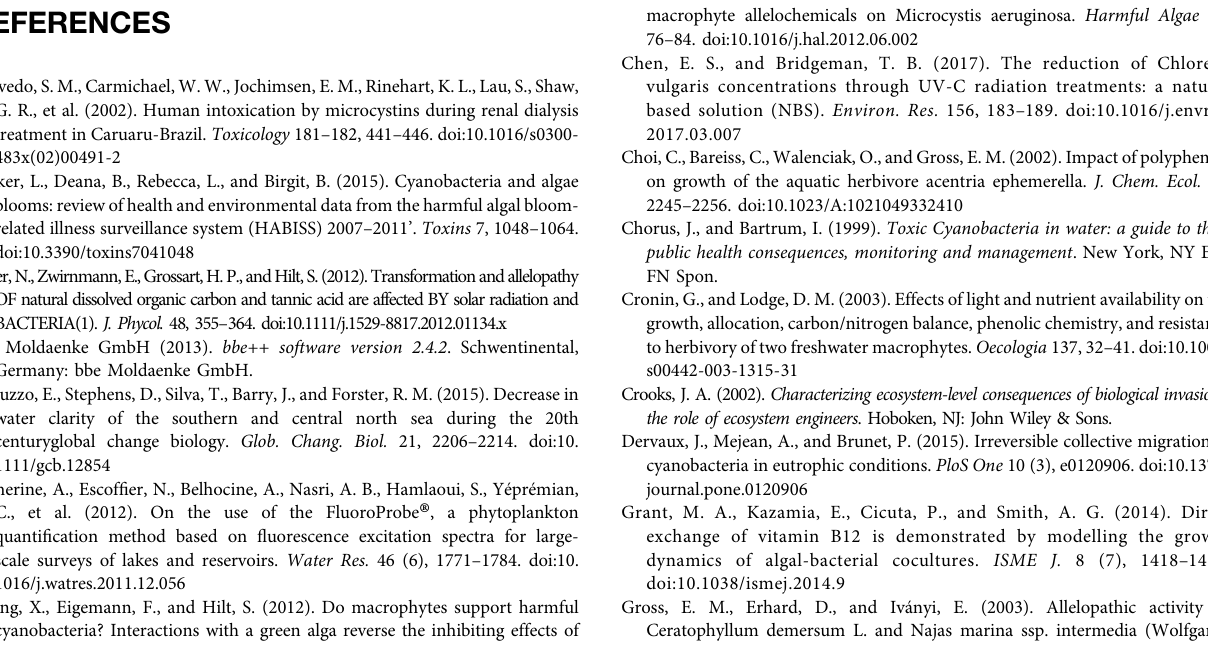
SUPPLEMENTARY FIGURE S1. The change in the number of phytoplankton cells over time under varying conditions. All fi gures are linear regression models indicating the average change in the number of cells between the different treatments. The shaded grey area represents the 95% con fi dence interval. The dotted line across the bottom of each graph represents 0 cells per ml. The solid red line represents Chlorella cell numbers, and the dashed blue line represents Synechocystis cell numbers. The red and blue circles represent the average Chlorella and Synechocystis cell numbers at each time point respectively, the error bars indicate the standard error. The underlined red numbers indicate the intercept, coef fi cient, R2 value and P value of the regression models relating to Chlorella. The blue, non-underlined numbers, represent the same values for the regression models relating to Synechocystis. Figures (a) , (b) and (c) , represent the results for each plant type, H. ranunculoides, C. helmsii and Fake plant respectively. The vertical facets (Chlorella, Mixed and Synechocystis) refer to monoculture treatments for each species, and the co-culture treatments. The horizontal facet ( Crushed, Whole and Fake ) refers to the state of the